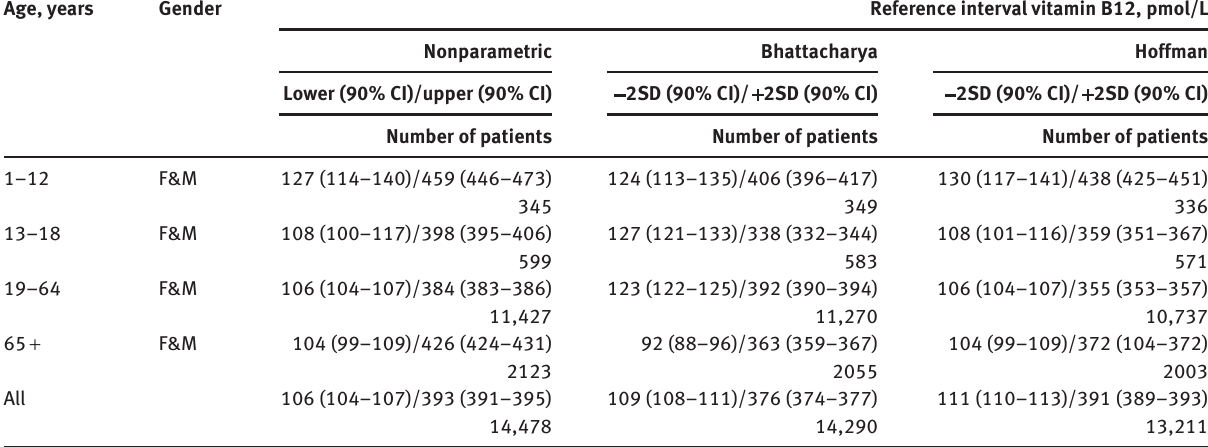
Vitamin B12, pmol/L MCH, mean corpuscular hemoglobin; MCHC, mean corpuscular hemoglobin concentration; MCV, mean corpuscular volume; RDW, red cell distribution width; SD, standard deviation. Table 2: Serum vitamin B12, in the age groups and in the entire sample. Age, years Gender Reference interval vitamin B12,